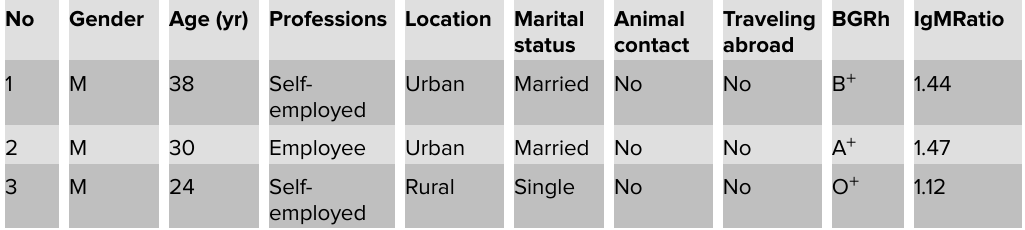
Table 3: The status of studied variables in blood donors with a positive IgM West Nile virus laboratory test.